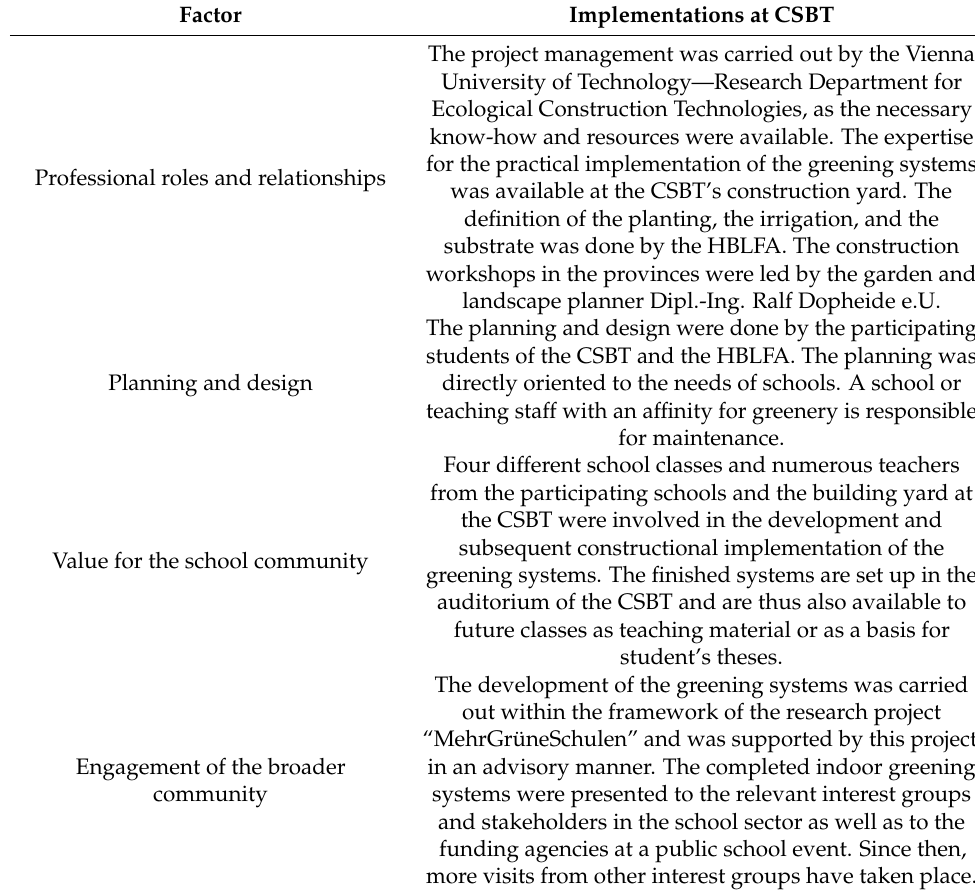
Table 1. The four influencing factors for the implementation of greening measures according to Onori et al. [13] applied to the implementations at Camillo Sitte Bautechnikum. Factor Implementations at CSBT